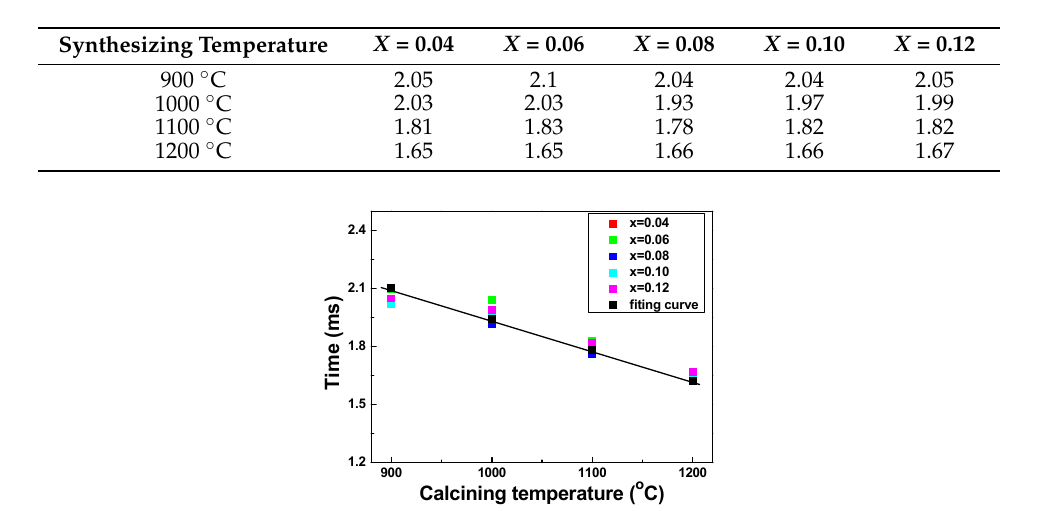
Figure 6. Fitting curve of lifetime for Sr 2 − x Eu x ZnMoO 6 phosphors as a function of the synthesizing temperature and concentration of Eu 3+ ions.